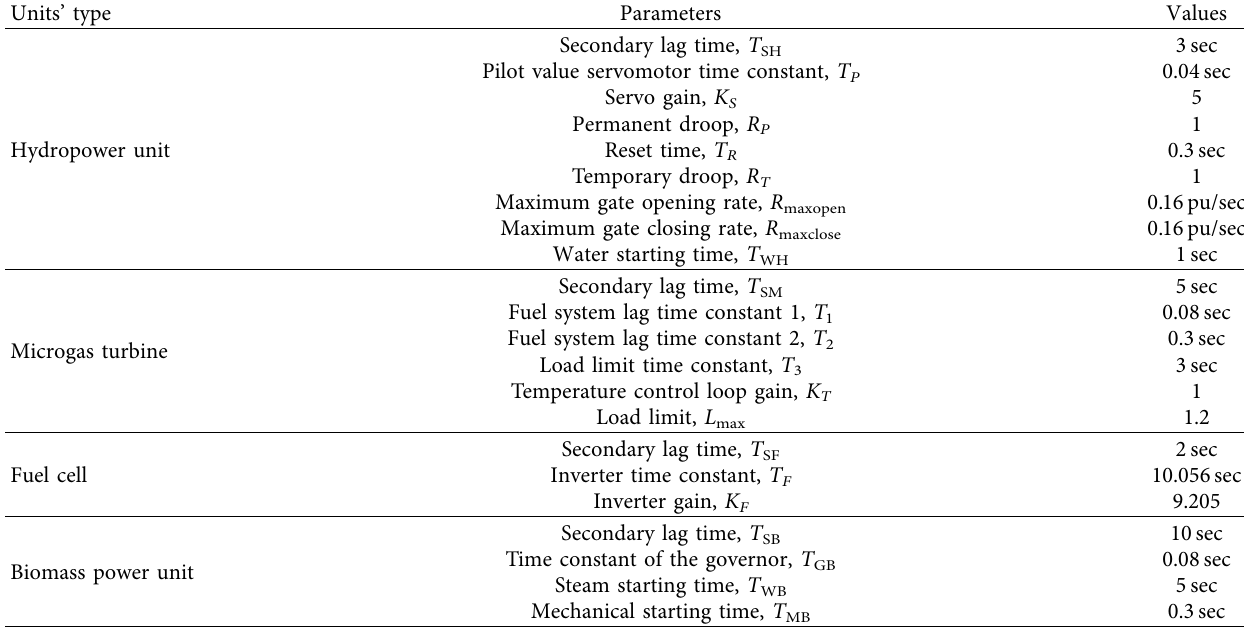
Table 1: Te parameters of the three-area polymorphic energy system model.